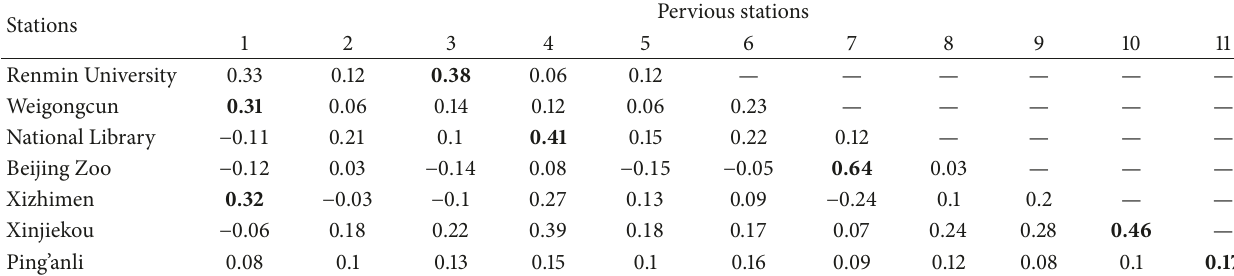
Table 11: Correlation coefficients of the dwell time in off-peak periods.